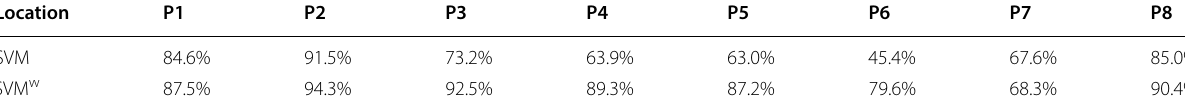
Table 4 The classification rate of SVM classification and SVM classification without issues Location